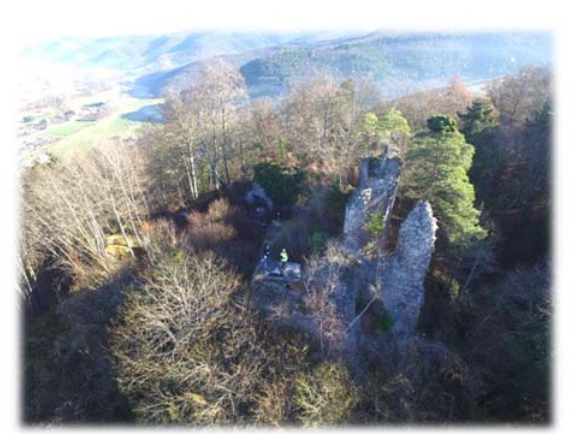
Figure 1: UAV view of the ruins of